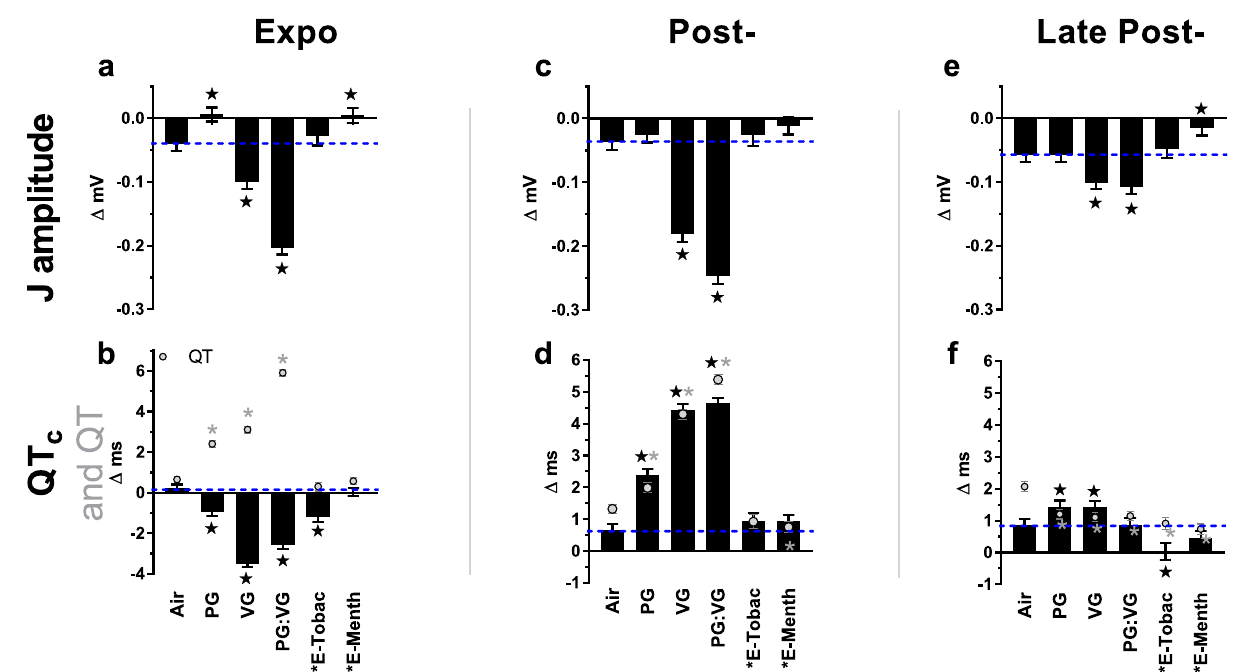
Fig. 5 | Inhalation exposure to E-cig aerosols alters ventricular repolarization. Bars represent least square means (±SEM) of change from 5-min baseline in J amplitude, QT c interval, and uncorrected QT (gray circles) according to exposure phases ( a – f ). Signi fi cance determined by two-sided P <0.05 (vs. Air: star for J amplitudeand QTcand gray asteriskforQT) in mixedmodelanalyses. Blue dashes